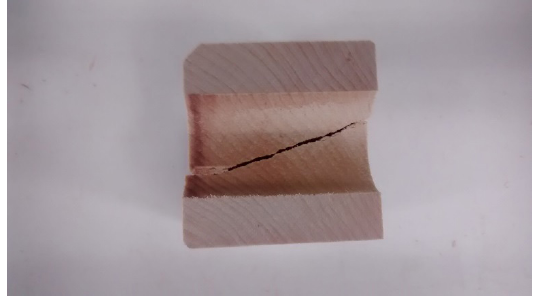
Figure 18. Typical failure mode of 45-degree direction specimen in perpendicular tension perpendicular to grain